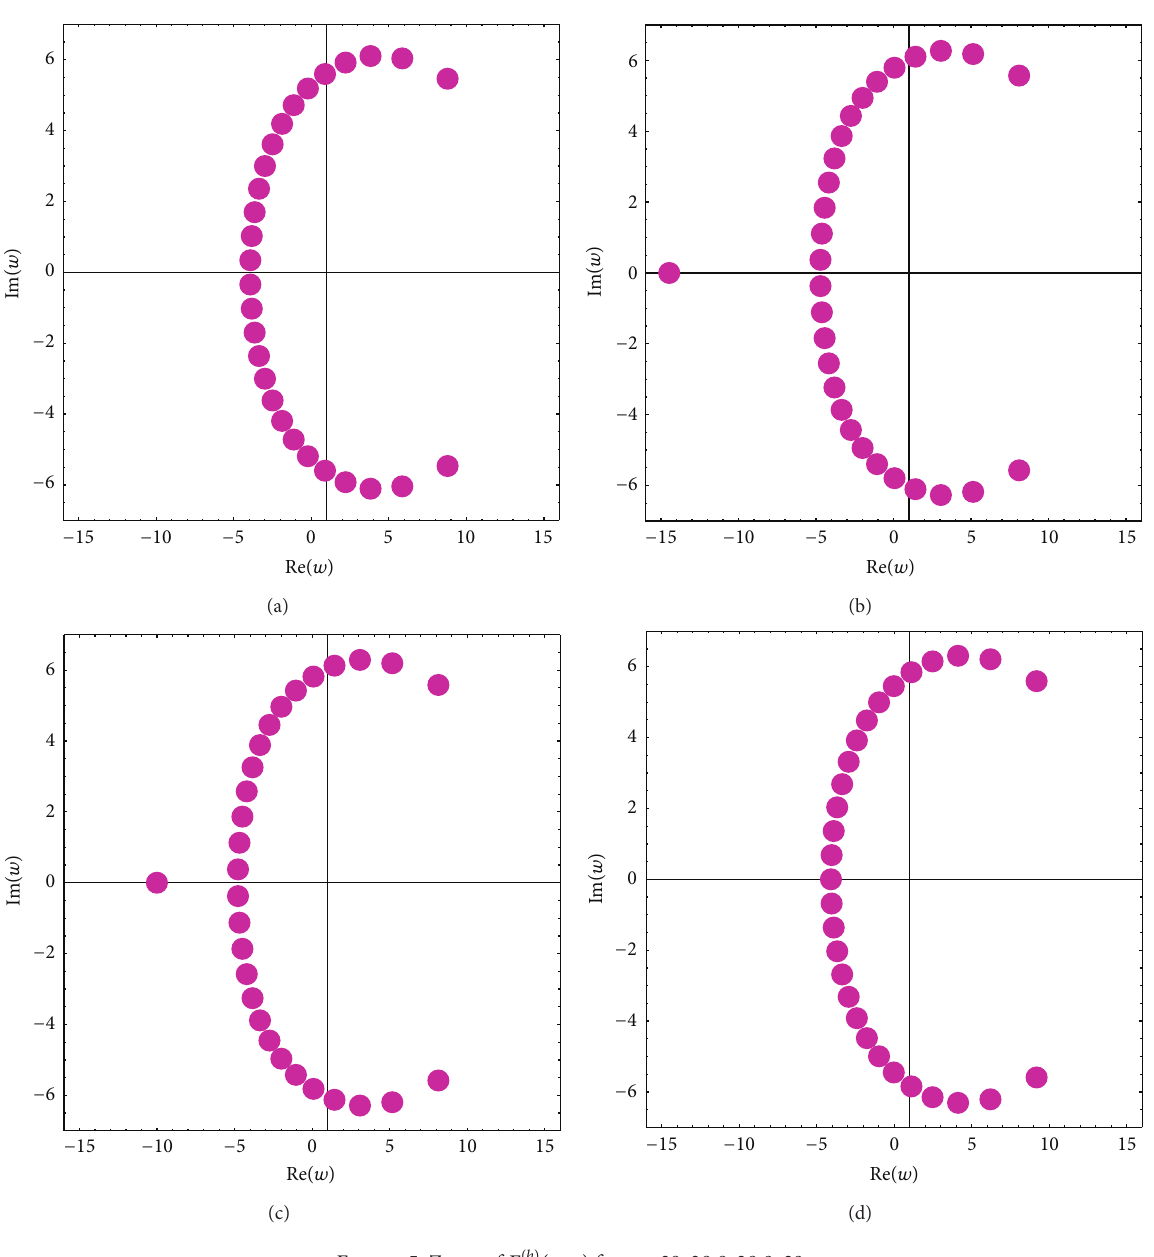
Figure 5: Zeros of 𝐸 (ℎ) 𝑞 (𝑠,𝑤) for 𝑠 = 28, 28.8, 28.9, 29